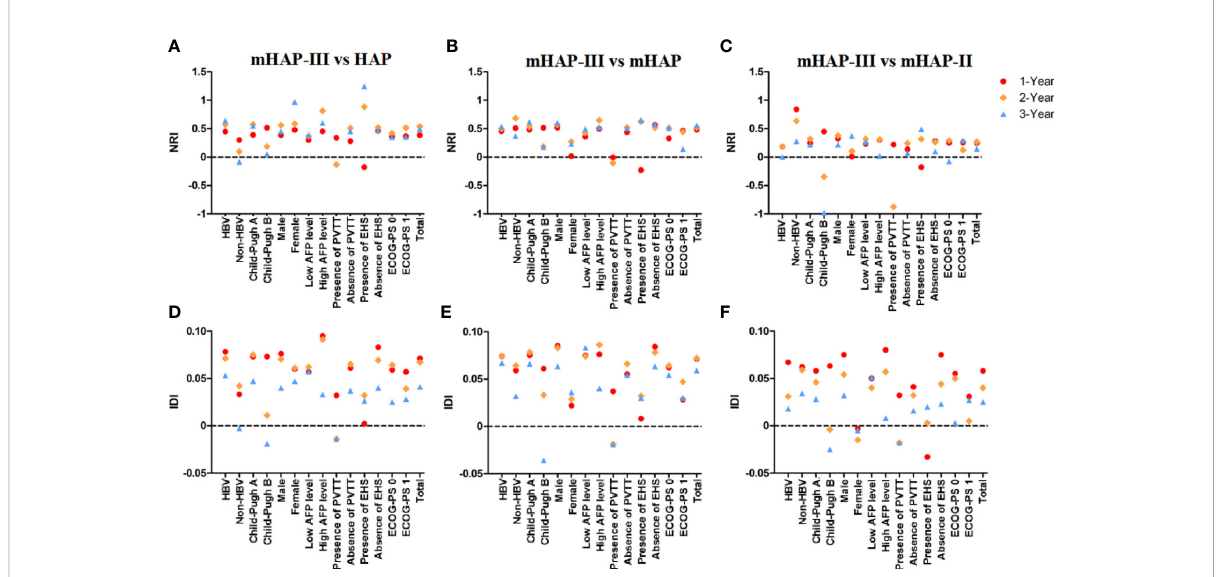
FIGURE 6 Net reclassi fi cation index (NRI) and integrated discrimination improvement (IDI) statistics. (A – C) NRI for mHAP-III vs. HAP, mHAP-III vs. mHAP, and mHAP-III vs. mHAP-II. (D – F) IDI for mHAP-III vs. HAP, mHAP-III vs. mHAP, and mHAP-III vs. mHAP-II. HAP, hepatoma arterial-embolization prognostic; mHAP, modi fi ed HAP.